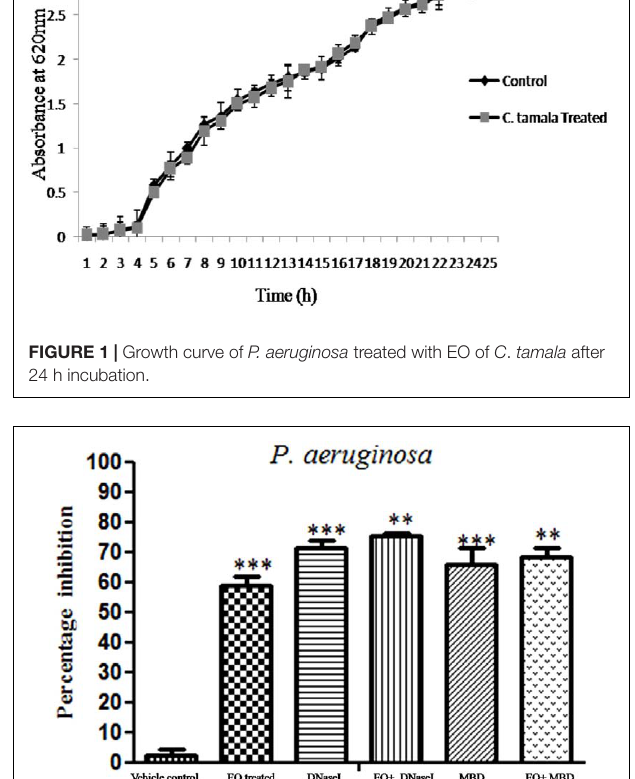
FIGURE 2 | Percentage inhibition of P. aeruginosa young biofilm. Mean values of triplicate of independent experiments ± SD are shown. One-way ANOVA test demonstrates significant difference between the control and the test. Double asterisk indicates significant at P ≤ 0.01 and triple asterisk indicates significant at P ≤